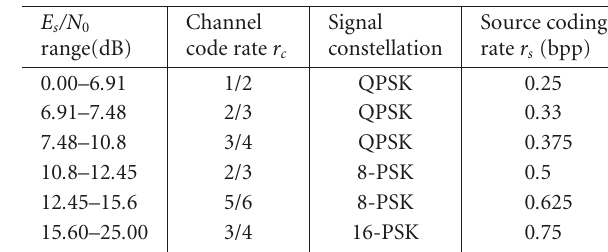
Table 1: The best choice of channel code rate and signal constella- tion (and their associated source coding rate) corresponding to dif- ferent E s /N 0 ranges based on Figure 4 for our adaptive TCM system when transmitting the SPIHT compressed 512 using 65,536